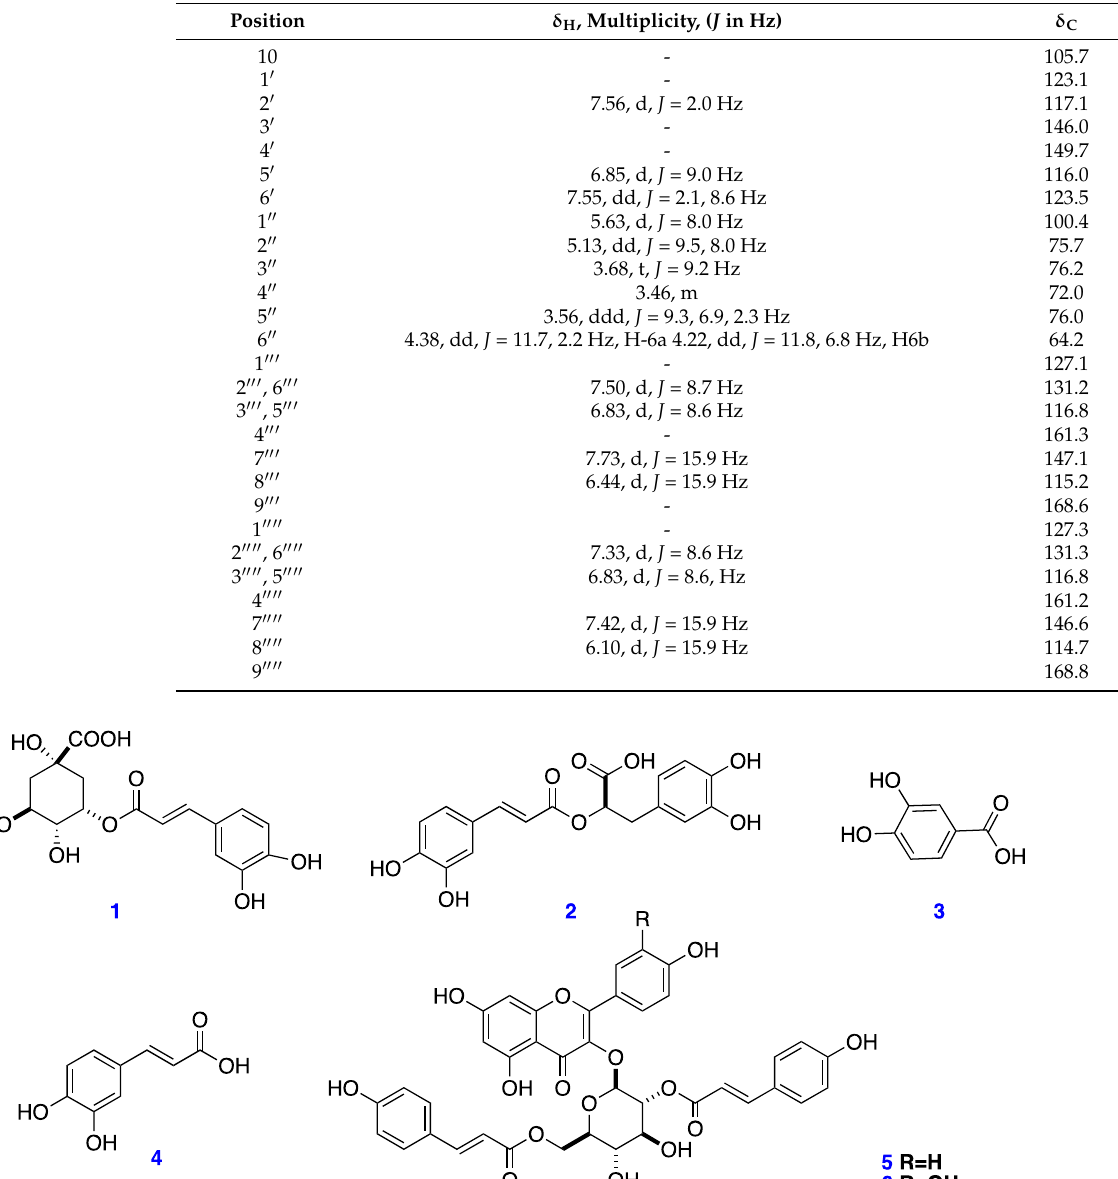
Table 1. Spectral data of compound 6.